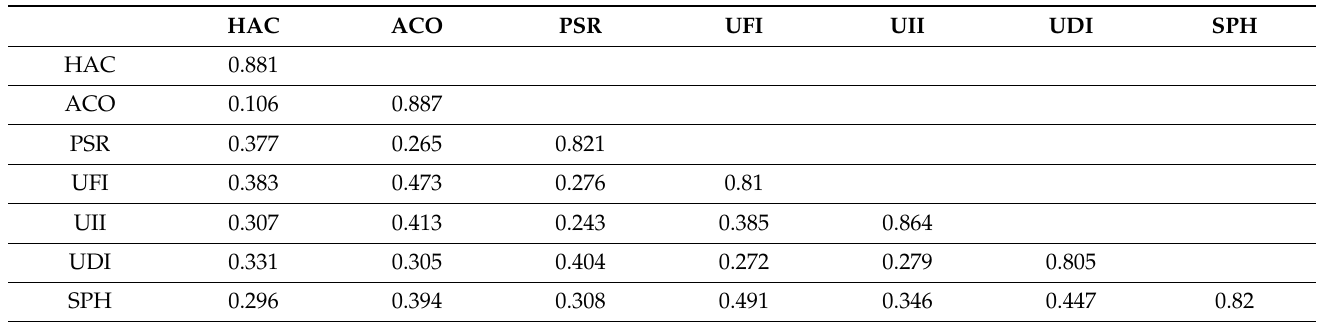
Table 5. Fornell–Larcker criterion test